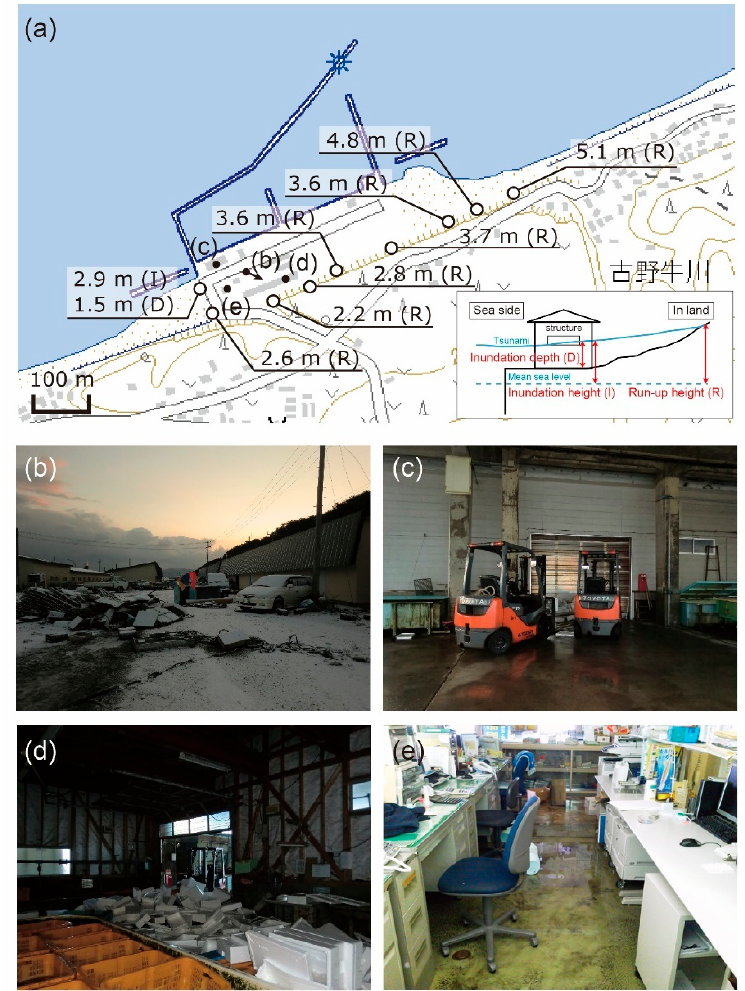
Figure 2. Example of fishery port facilities and equipment damage at Noushi fishery port (6 on